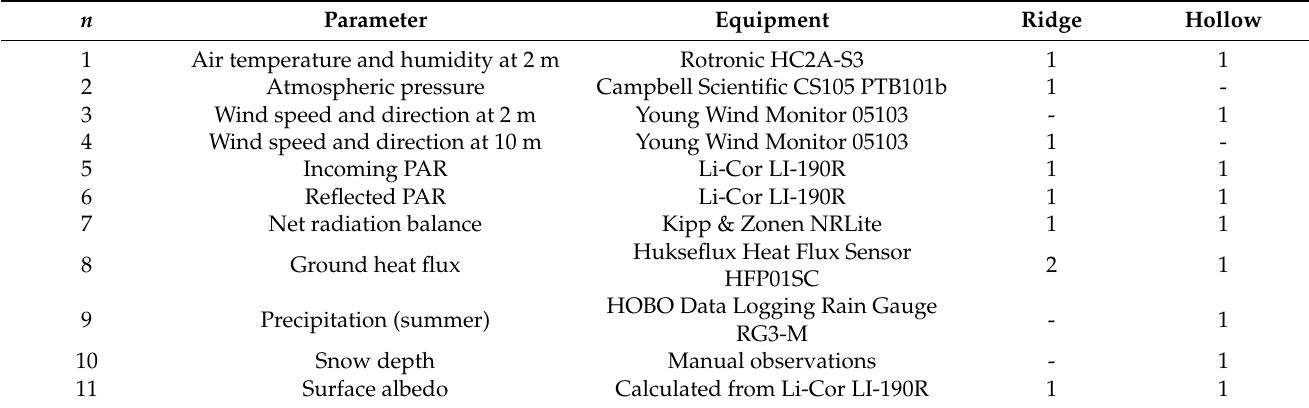
Table A1. List of sensors, parameters and installation site at Mukhrino field station, 2010–2019.